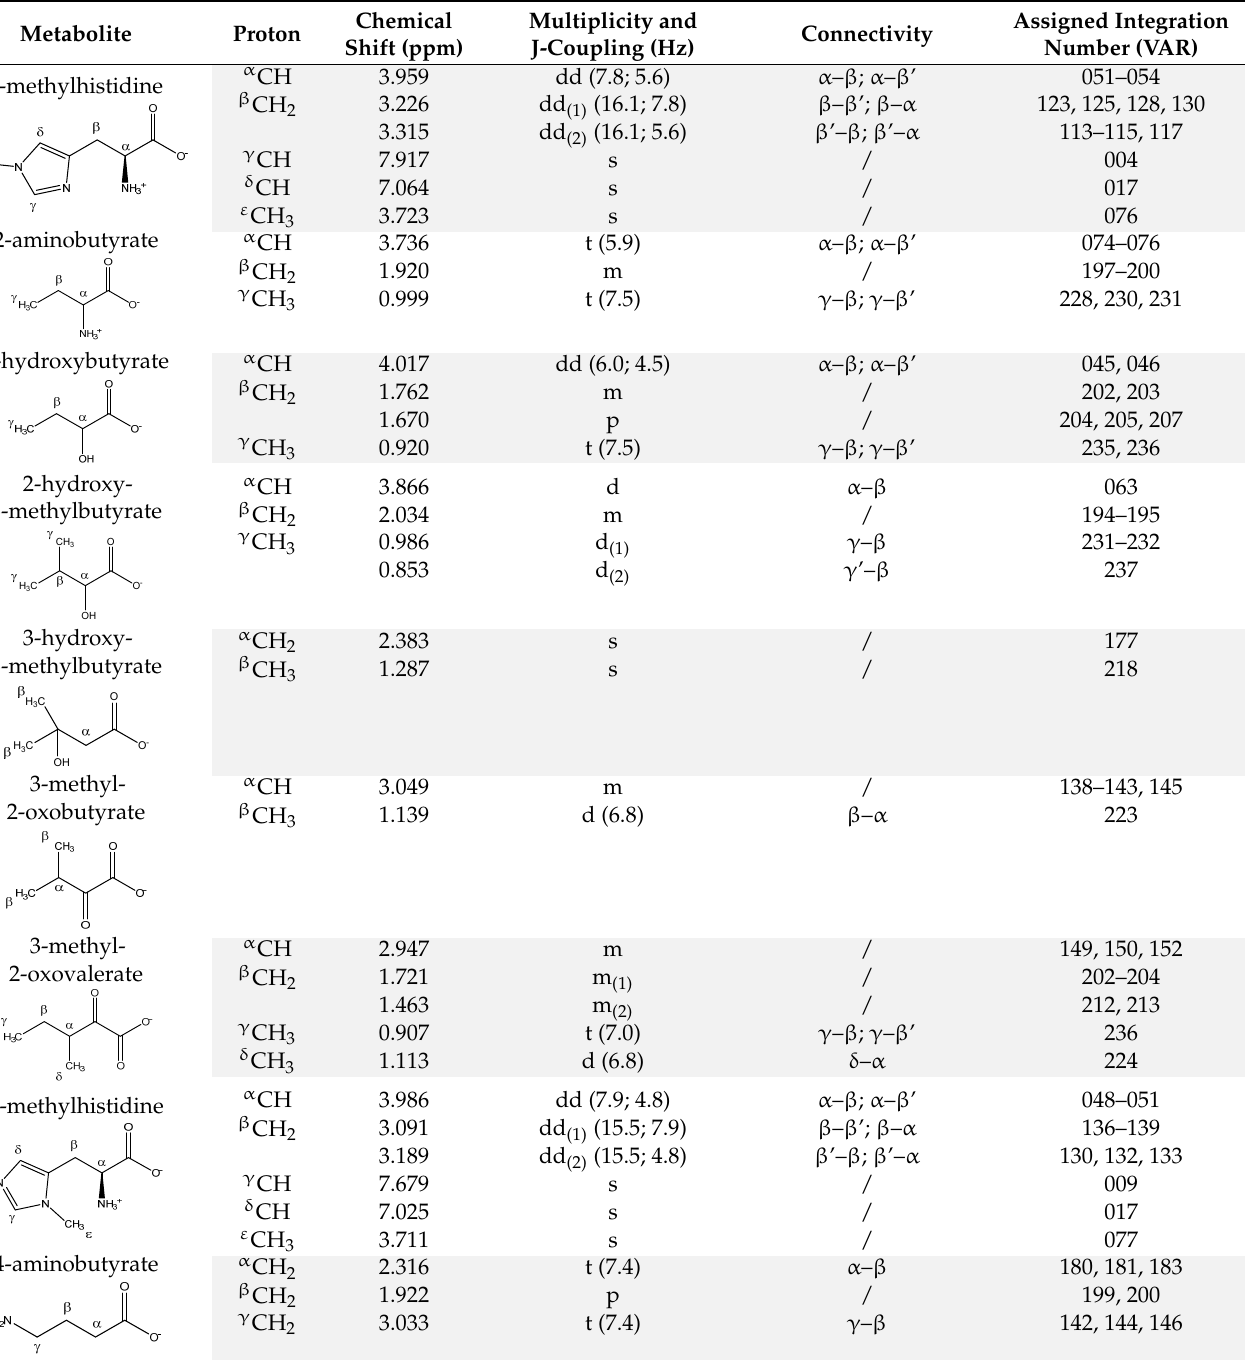
Table 1. Summary of the 62 spiked metabolites and their chemical shifts, multiplicity, and J-coupling. The assigned integration numbers for each proton are listed, and can be linked with the integration regions shown in Table S1. d: doublet; dd: double doublet; ddd: doublet of double doublet; dq: double quadruplet; dt: double triplet; m: multiplet; p: pentaplet; q: quadruplet; s: singlet; t: triplet.